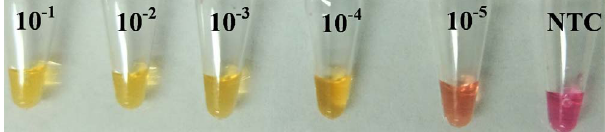
Fig. 2. Sensitivity of the colourimetric LAMP assay as expressed through a 10-fold serial dilution of positive control gDNA of H. contortus . NTC: Non-template